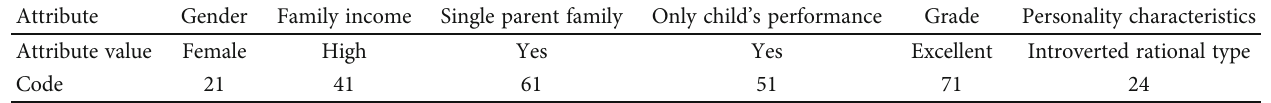
Table 1: Student ’ s attribute code table.